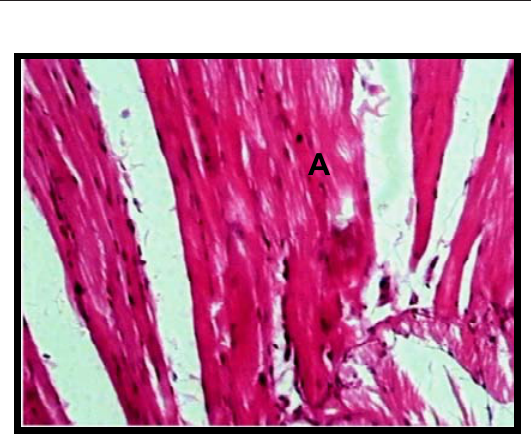
FIGURA 12 – Fotomicrografia de um animal do grupo GE7D.